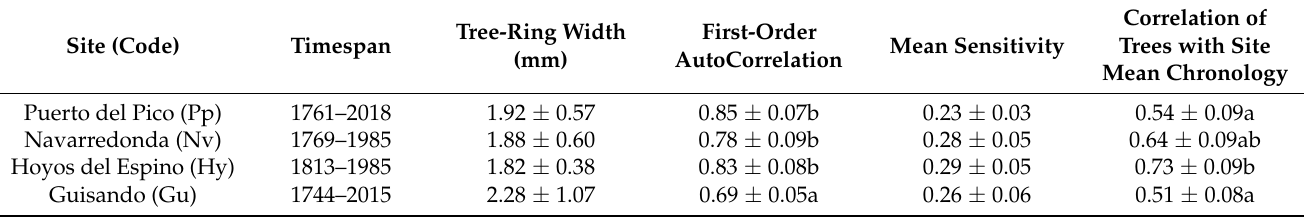
Table 2. Tree-ring data and statistics for the common period 1920–1985. Values are means ± standard deviations. Different letters indicate significant ( p < 0.05) differences between sites according to Mann–Whitney